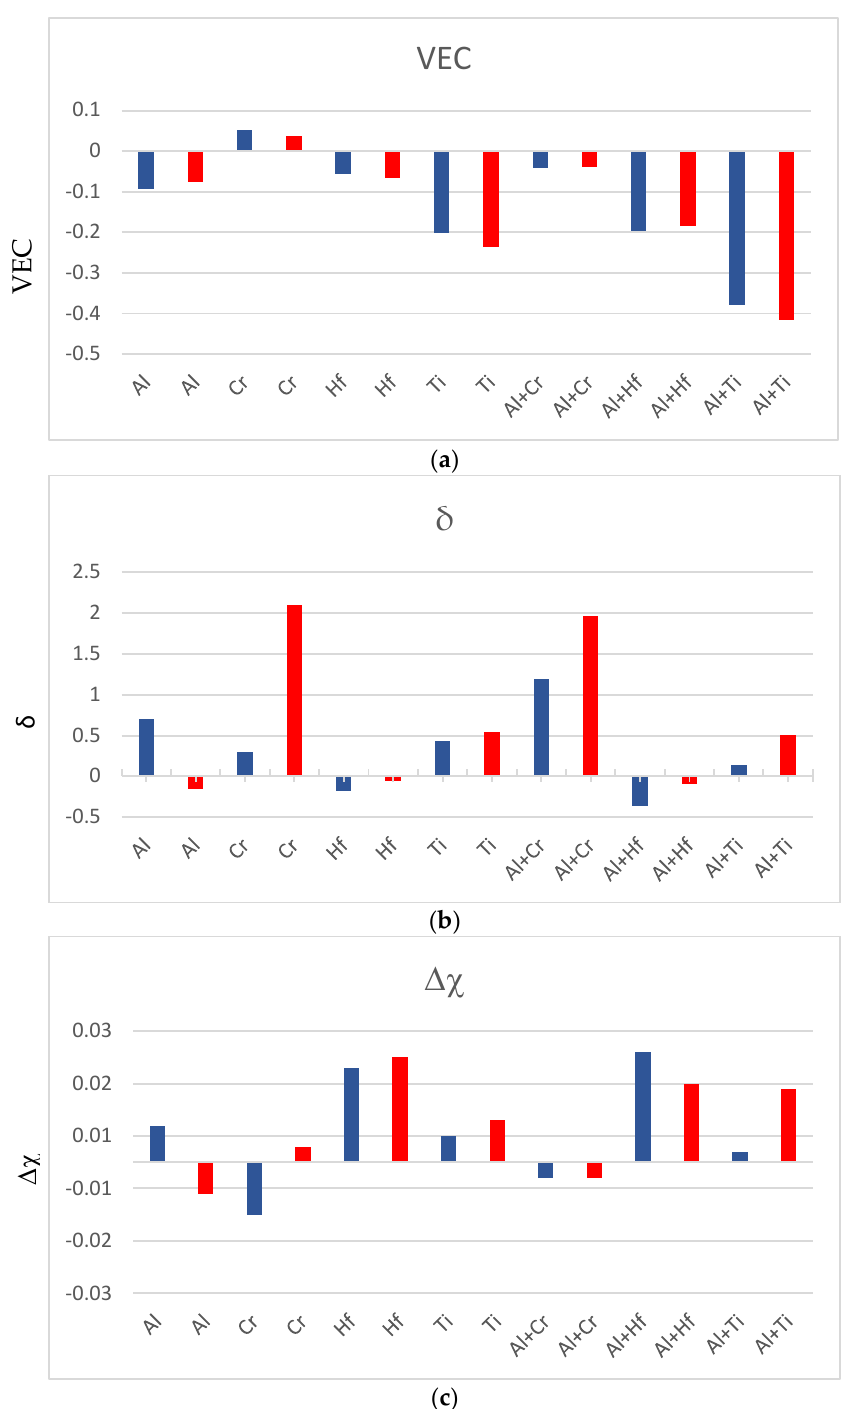
Figure 7. Effect of solute element(s) individually and in synergy on the parameters (ordinate) VEC, δ and ∆ χ of the Nb ss in cast microstructures (blue colour) and in heat treated microstructures (red colour). Data is shown as the difference from the values of the alloys NbSiTiHf-5Al and NbSiTiHf-5Al-5Cr, for example, the effect of Al on the parameter VEC is VEC Al = VEC Nbss NbSiTiHf-5Al − VEC Nbss YG3 = 4.586 − 4.679 = − 0.093, similarly δ Al = δ Nbss NbSiTiHf-5Al − δ Nbss YG3 = 4.34 − 3.64 = +0.7. The nominal composition of the alloy YG3 is Nb-24Ti-18Si-5Hf [26]. The Al, Hf, and Ti concentrations in the Nb 5 Si 3 silicide are indicated in Figure 8, which shows the trends of the Si versus Ti, Al versus Ti, and Hf versus Nb concentrations in Nb 5 Si 3 in Nb-silicide